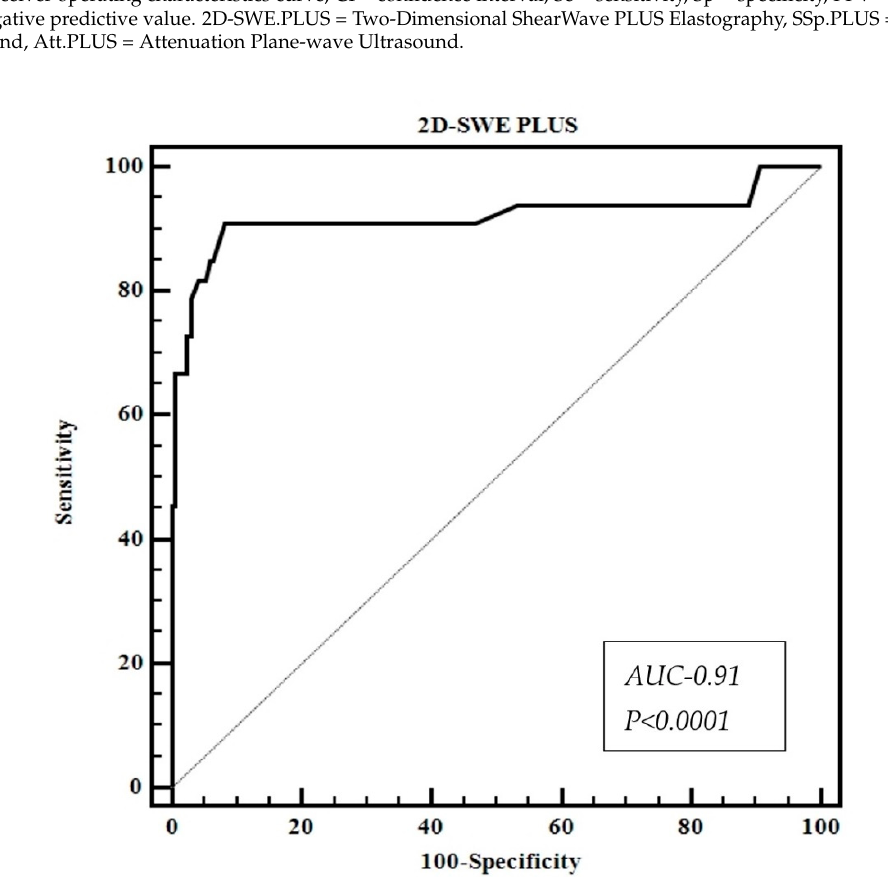
Figure 5. Performance of 2D-SWE.PLUS for predicting significant fibrosis (F ≥